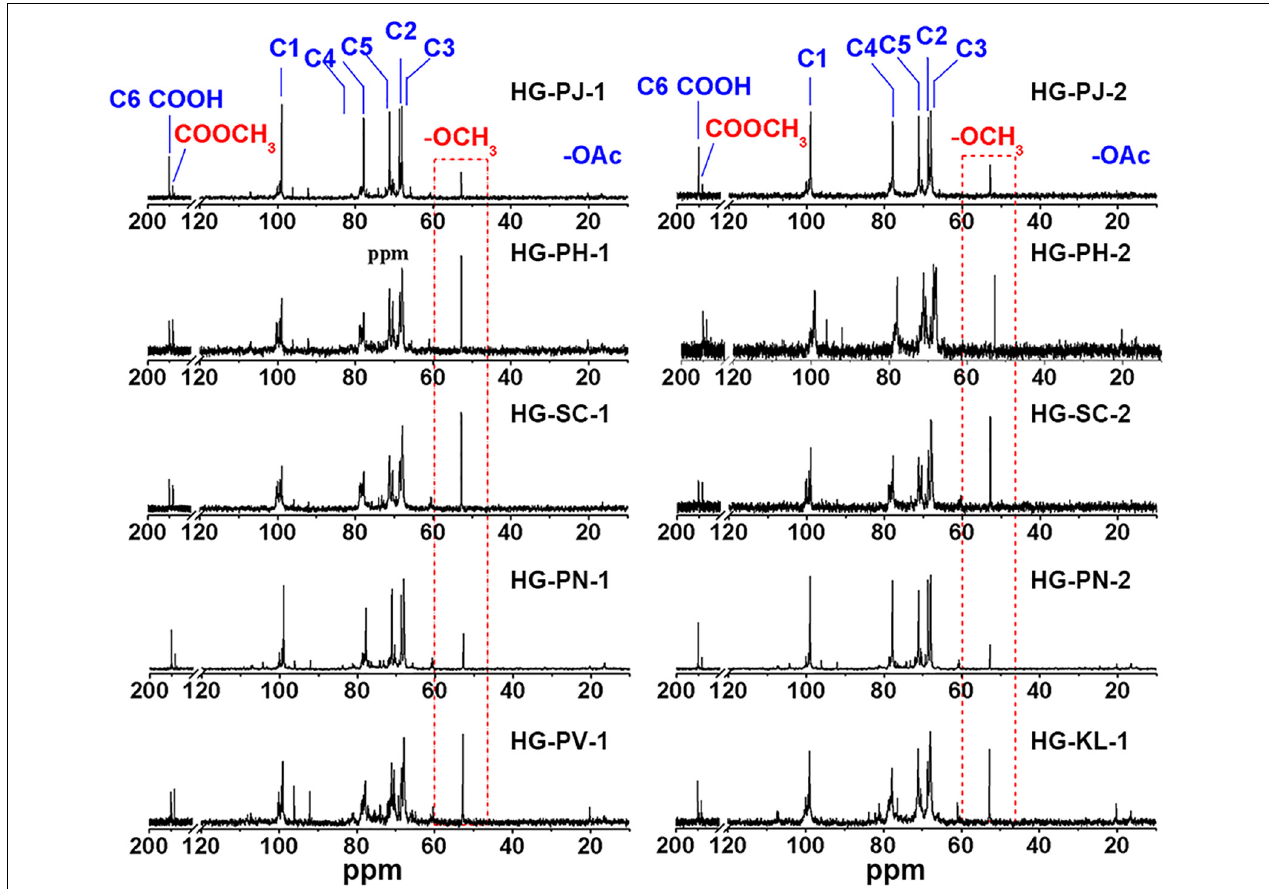
FIGURE 2 | 13 C NMR spectrum of HG